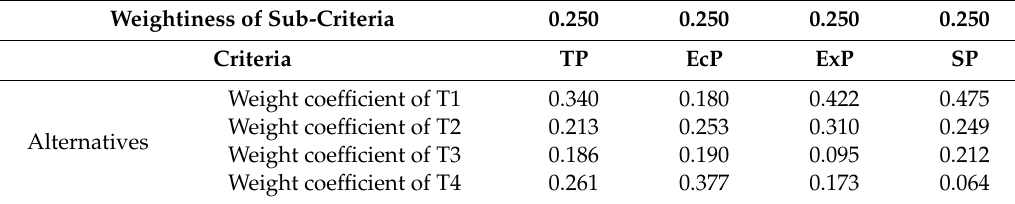
Table 16. Calculated weight coe ffi cients by AHP